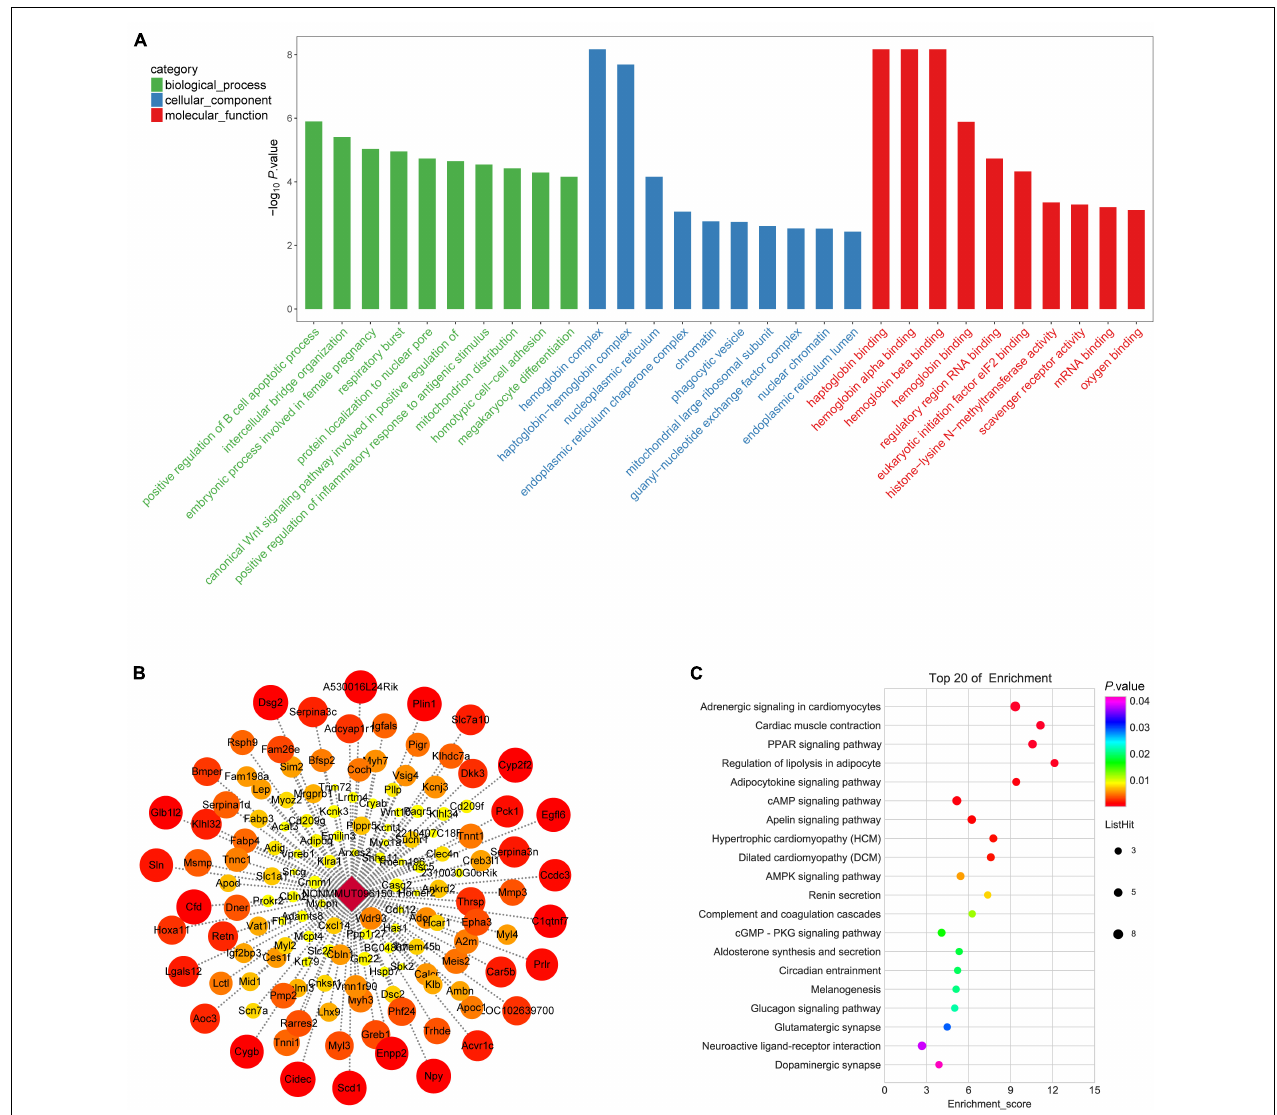
FIGURE 7 | Gene Ontology (GO) annotations for long non-coding RNAs (lncRNAs) in in OVX. (A) The figure shows top 10 most enriched GO for DelncRNA in ontologies of biological processes, cellular component, and molecular function. (B) mRNAs that coexpressed with lncRNA RP11-222K16.2. Weighted correlation network analysis based on Pearson’s correlation was used to estimate the correlation coefficient between the lncRNA and coding genes, and the soft threshold was set at 0.8. (C) KEGG pathway annotations of the lncRNA